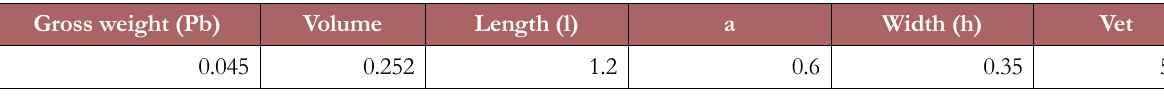
Table 8. Volumetric capacity of the product